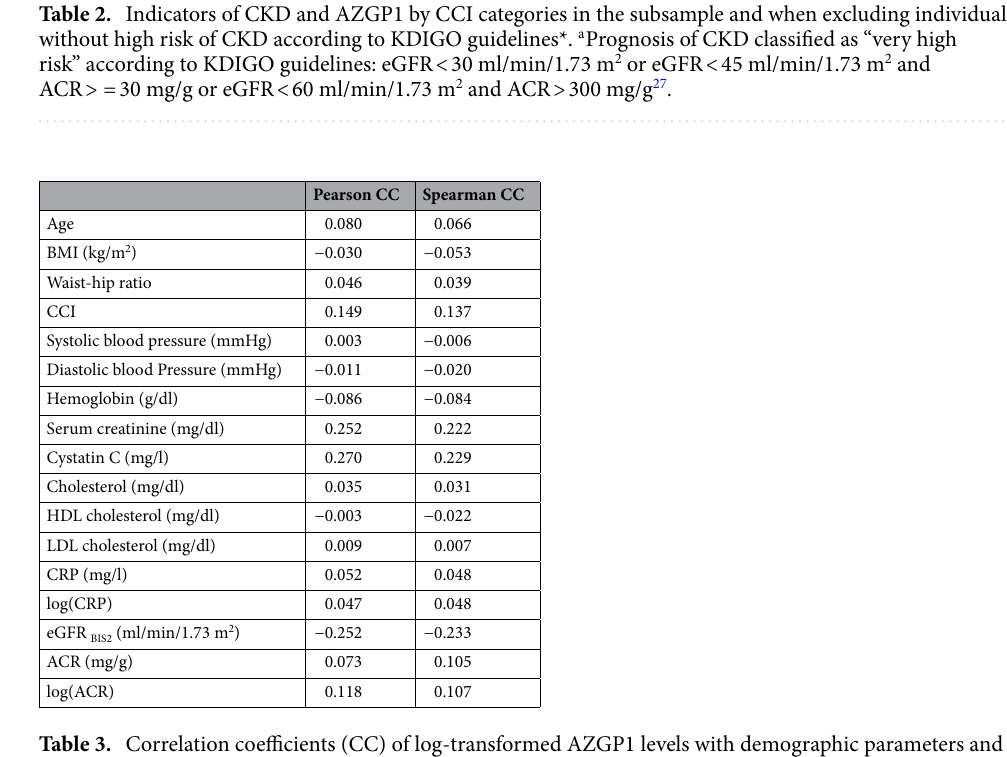
Table 3. Correlation coefficients (CC) of log-transformed AZGP1 levels with demographic parameters and biomarkers. ACR albumin creatinine ratio, BMI body mass index, CCI Charlson comorbidity index, CRP c-reactive protein, eGFR estimated glomerular filtration rate, HDL high-density lipoprotein, LDL low-density lipoprotein, log natural